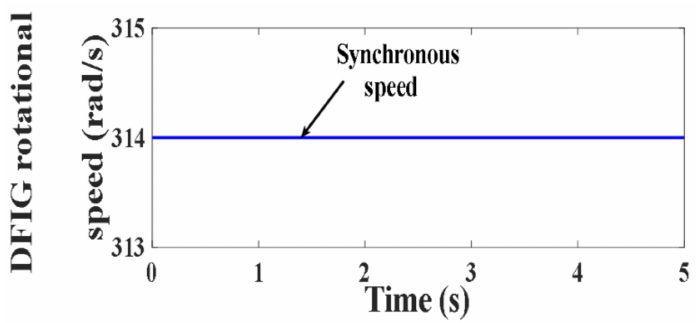
Figure 16. Prime mover operating speed